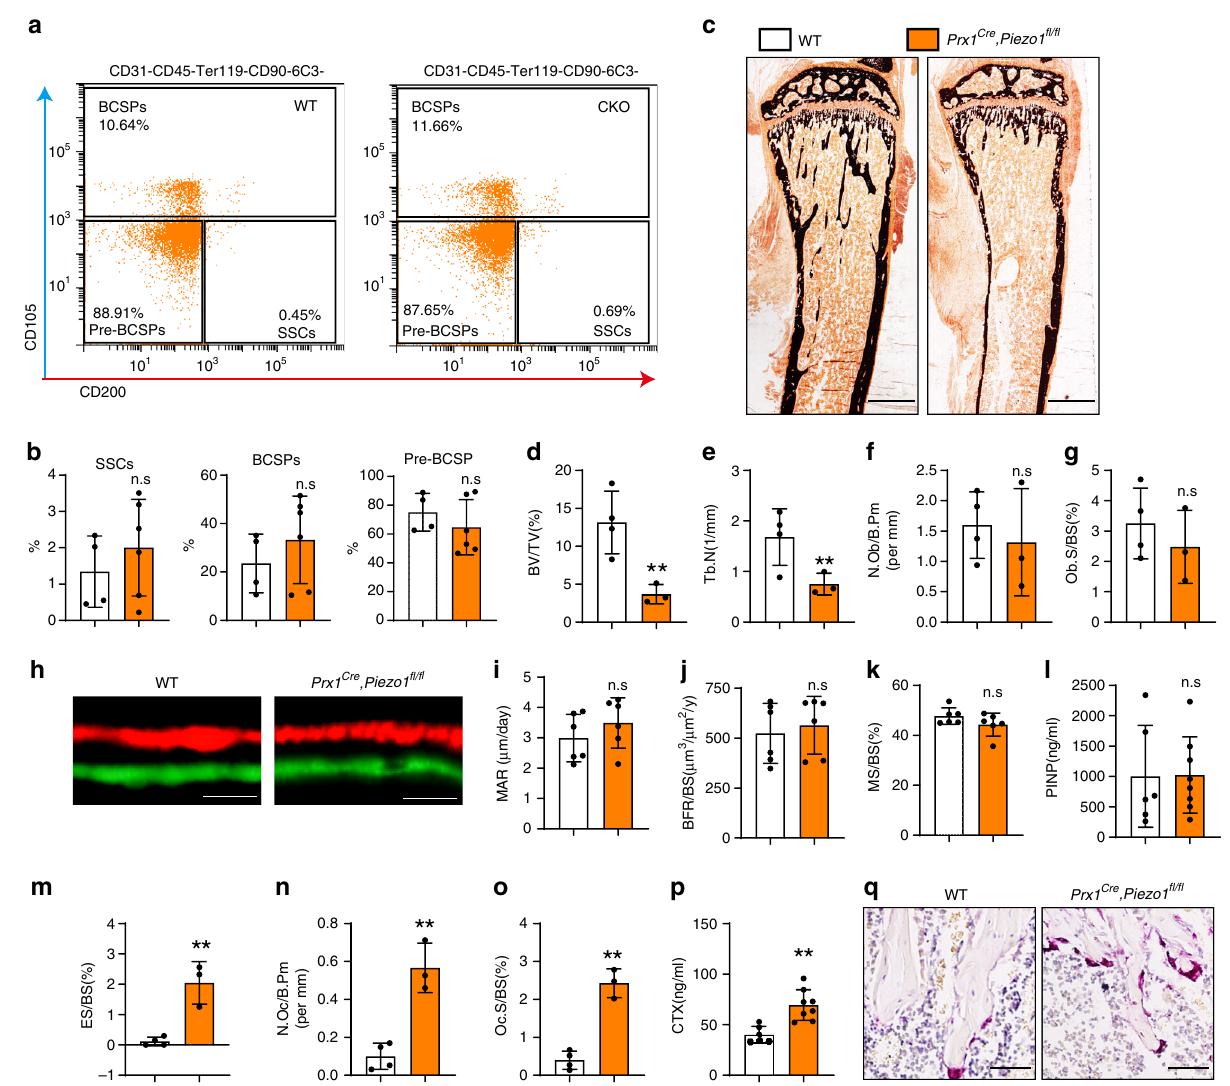
Fig. 2 Loss of Piezo1 in osteoblastic cells resulted in increased bone resorption. a , b FACS analysis of mSSCs, mBSCPs and mPre-BSCPs of bone marrow cells of 6-week-old male WT and Prx1 Cre , Piezo1 fl / fl mice. Data are mean ± SD, WT, n = 4, CKO, n = 6. c Representative images of Von kossa staining of 6- week-old male WT and Prx1 Cre , Piezo1 fl / fl mice. Scale bar = 500 μ m d – g Histomorphometric analysis of proximal tibias from 6-week-old male WT and Prx1 Cre , Piezo1 fl / fl mice for bone volume per tissue volume (BV/TV) ( d ), trabecular number (Tb.N) ( e ), number of osteoblasts per bone perimeter (N.Ob/B. Pm) ( f ), osteoblast surface per bone surface (Ob.S/BS) ( g ). Data are mean ± SD, WT, n = 4, CKO, n = 3. h Representative images of dual Calcein-Alizarin red S labeling of proximal tibias from 6-week-old male WT and Prx1 Cre , Piezo1 fl / fl mice. Scale bar = 20 μ m, n = 6. i – k Quanti fi cation of mineral apposition rate (MAR) ( i ), bone formation rate normalized to bone surface (BFR/BS) ( j ) and mineralizing surface normalized to bone surface (MS/BS) ( k ) of endo- cortical and trabecular bones of proximal tibias from 6-week-old male WT and Prx1 Cre , Piezo1 fl / fl mice. Data are mean ± SD, n = 6. l Serum PINP levels in 6- week-old male WT and Prx1 Cre , Piezo1 fl / fl mice. Data are mean ± SD, WT, n = 6, CKO, n = 8. m – o Histomorphometric analysis of the images from ( c ) for eroded surface per bone surface (ES/BS) ( m ), number of osteoclasts per bone perimeter (N.Oc/B.Pm) ( n ) and osteoclast surface per bone surface (Oc.S/ BS) ( o ). Data are mean ± SD, WT, n = 4, CKO, n = 3. p Serum CTX-I levels in 6-week-old male WT and Prx1 Cre , Piezo1 fl / fl mice. Data are mean ± SD, WT, n = 6, CKO, n = 8. q Tartrate-resistant acid phosphatase (TRAP) staining of femurs isolated from 6-week-old male WT and Prx1 Cre , Piezo1 fl / fl mice. Scale bar = 50 μ m. * P < 0.05; ** P < 0.01. Two-tailed Student ’ s t test. Source data are provided in the Source Data